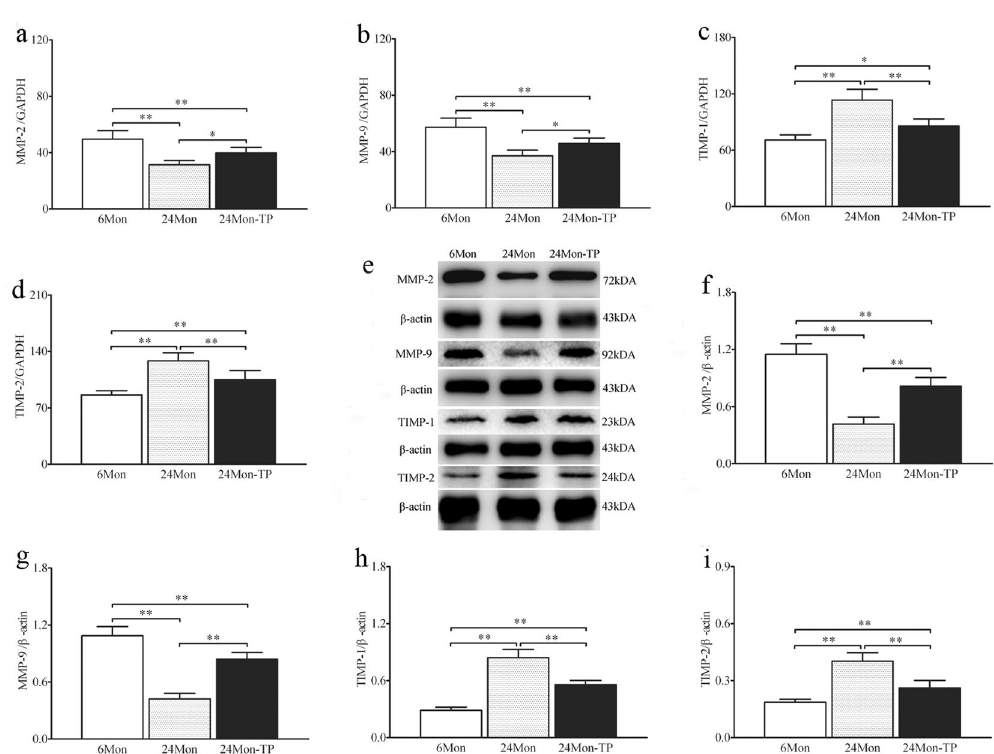
Figure 4. The effects of TP on the MMP-2, MMP-9, TIMP-1 and TIMP-2 in the renal tissue of aged rats. Bar graphs show MMP-2 mRNA ( a ), MMP-9 mRNA ( b ), TIMP-1 mRNA ( c ) and TIMP-2 mRNA ( d ). ( e ) Western blot study revealed MMP-2, MMP-9, TIMP-1 and TIMP-2 expression in the renal tissue. Bar graphs illustrate the protein expression of MMP-2 ( f ), MMP-9 ( g ), TIMP-1 ( h ) and TIMP-2 ( i ). The asterisks show significant differences ( * P < 0.05, ** P <